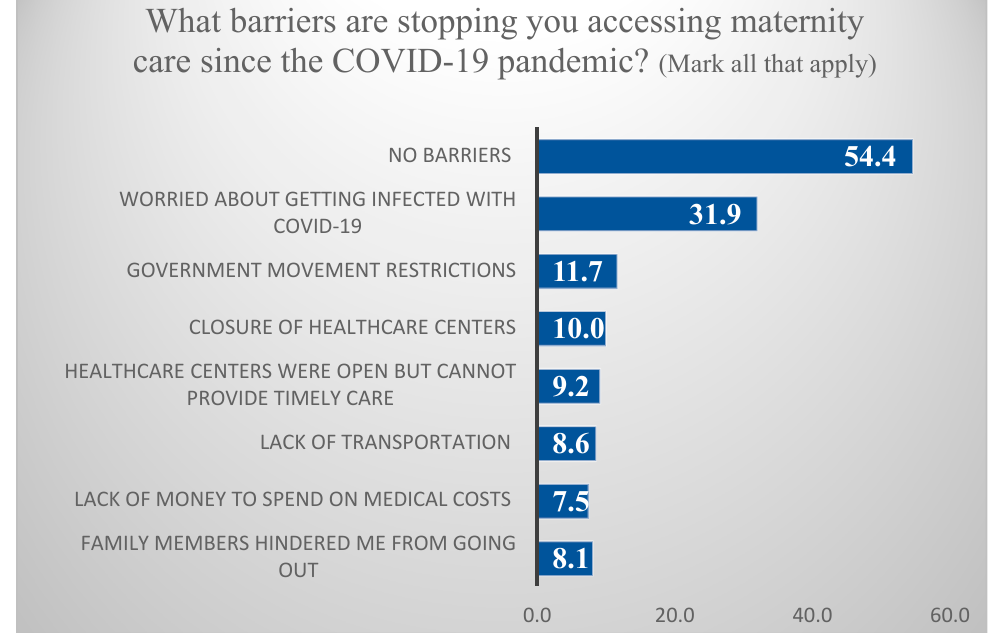
Figure 2. Percentage of barriers stopping the accessibility of postpartum women to maternity care during the COVID-19 pandemic. (Mark all that apply.)